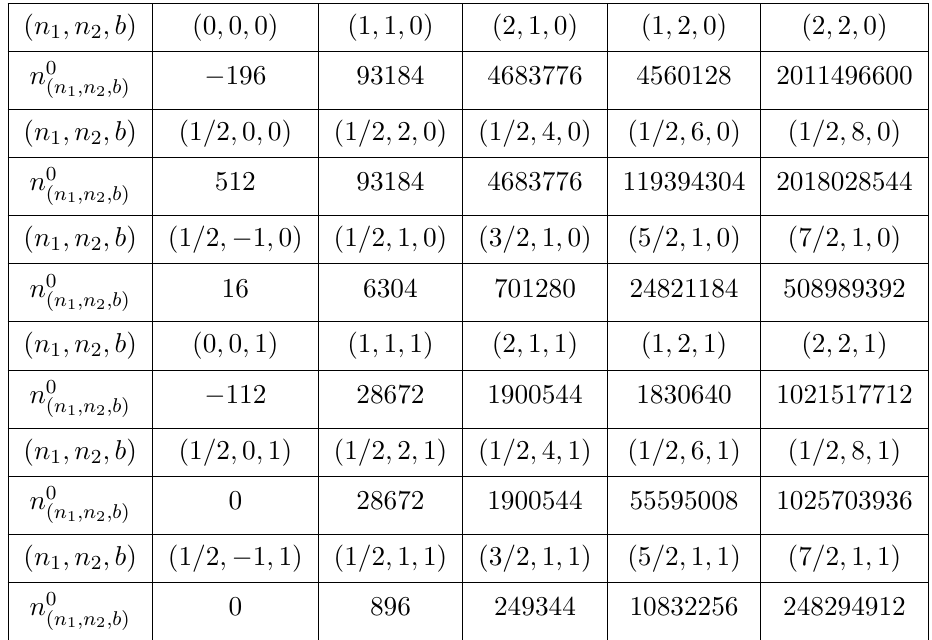
Table 4 . 2 A orbifold, standard embedding, with single Wilson line.